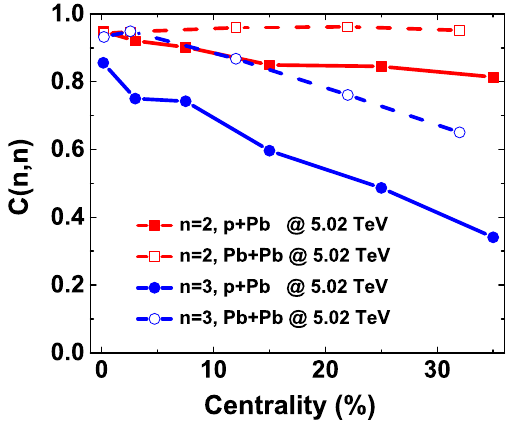
Fig. 12 (cid:12) n and v n in 0-0.3% and 20-30% 5.02 TeV p + Pb collisions for n = 2 , 3 with σ = 0 . 55 fm